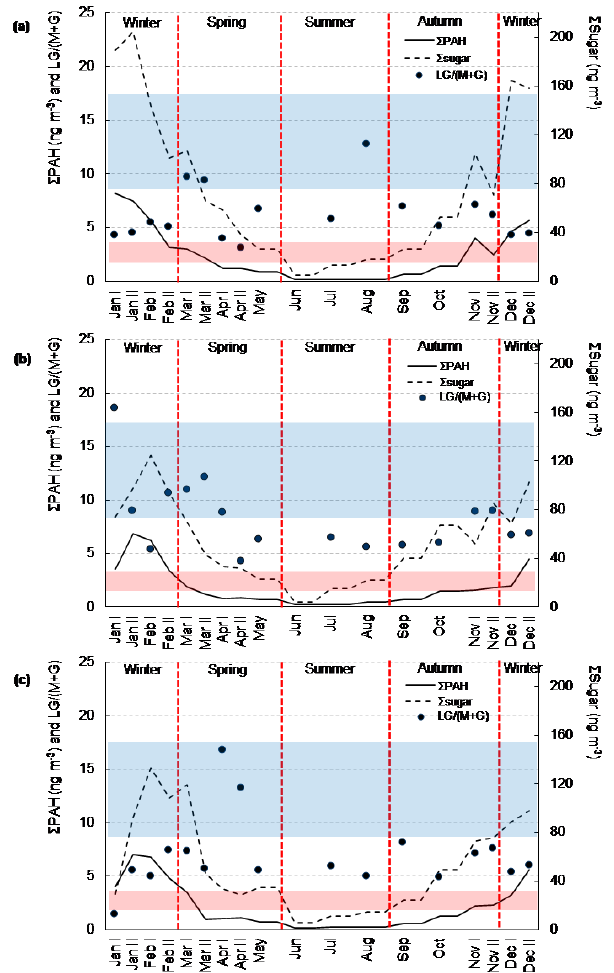
Figure 5. Seasonal variation of (cid:54) PAHs, (cid:54) sugars and levoglucosan / (mannosan + galactosan) (LG / (M + G) ratio in PM 10 collected from three sampling sites in 2017: (a) DE, (b) EN and (c) YJ. The blue and red zone represents the previously reported sugar ratio from hard and soft wood burning,